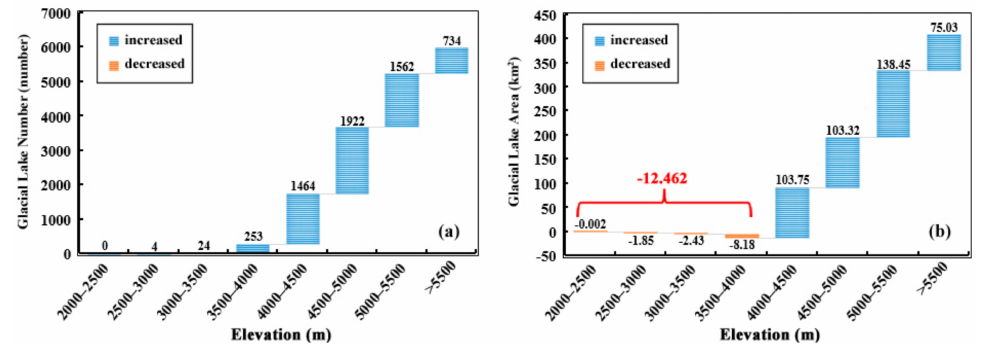
Figure 7. Changes in the number and area of glacial lakes at different elevations in the HKH-TMHA region from 1990 to 2020. ( a ) number, ( b )